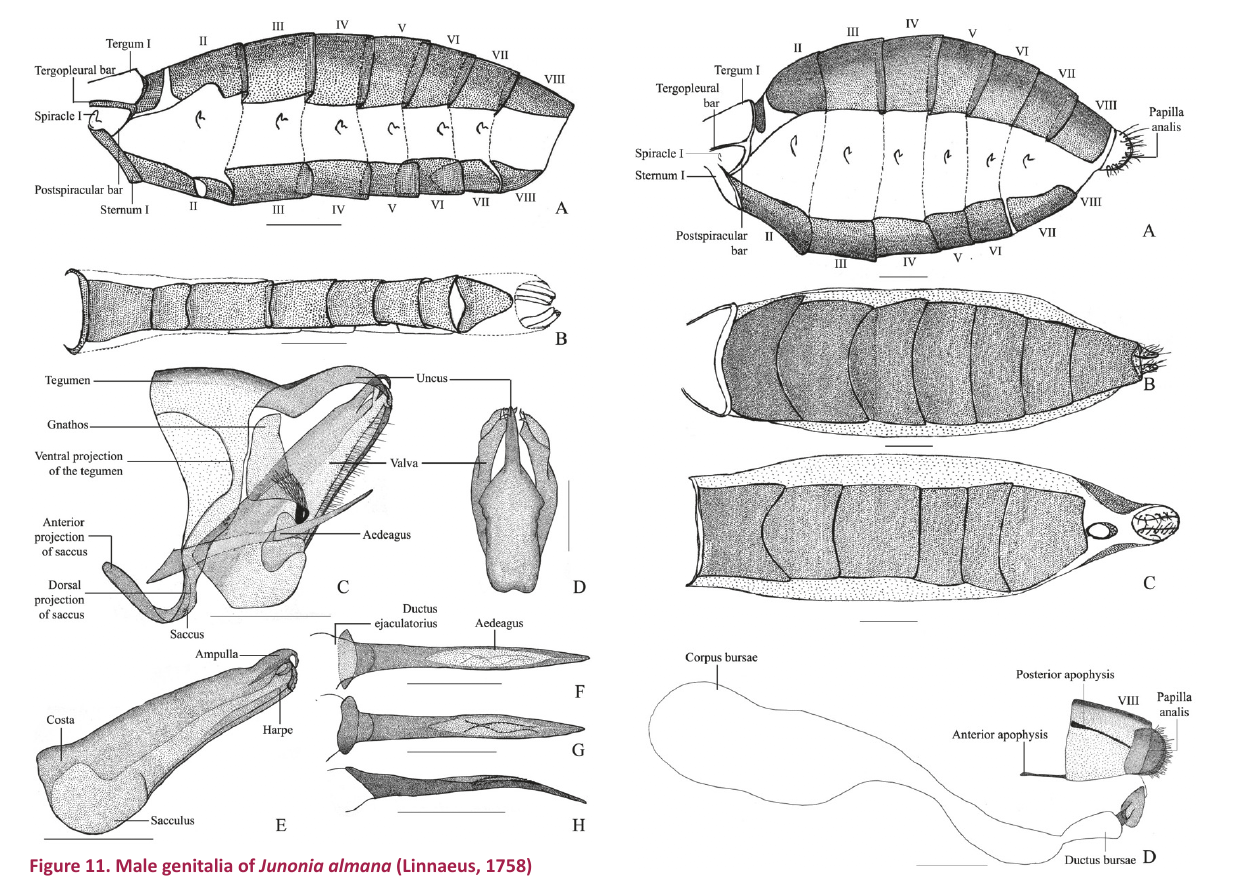
Figure 12. Female genitalia of Junonia almana (Linnaeus, 1758) A – C - abdomen (lateral, dorsal and ventral view); D - female genitalia (lateral view). Scale bar